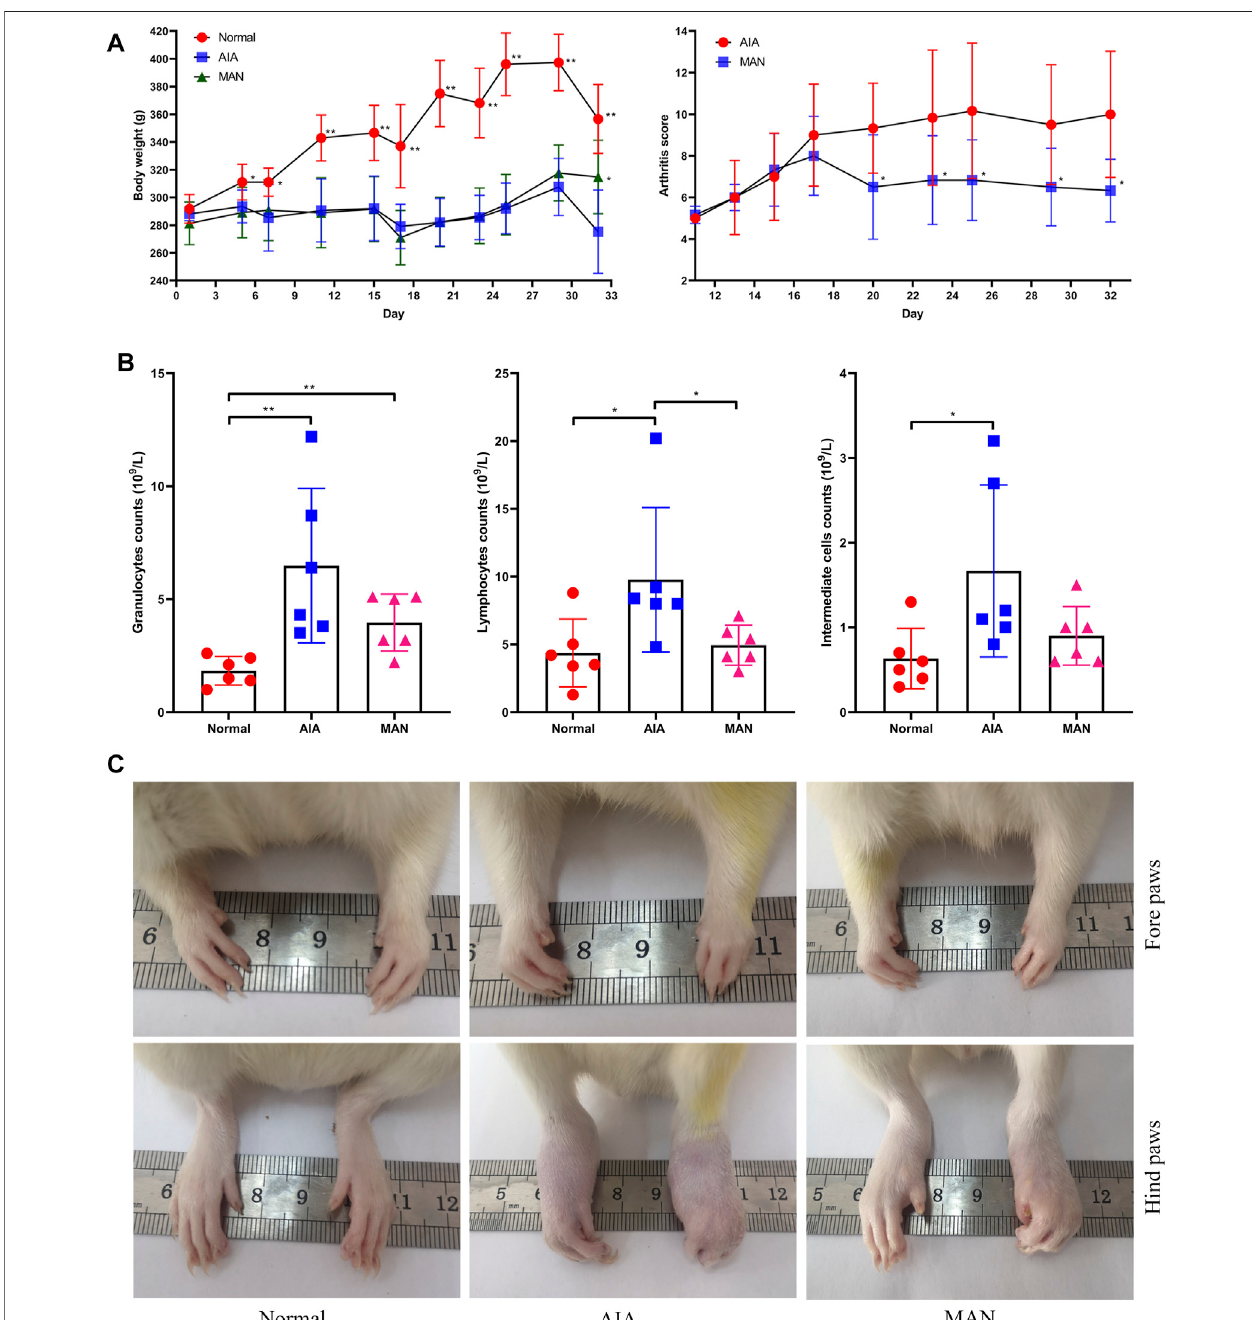
FIGURE 1 | MAN alleviated severity of AIA in rats after continuous oral treatment. (A) , periodic changes of arthritis scores and body weight of AIA rats ( n (cid:2) 6); (B) , CBC analysis of anticoagulation blood obtained upon the sacri fi ce of rats ( n (cid:2) 6); (C) , morphological observation of paws by the end of experimental period. Statistical signi fi cances in image A: * p < 0.05 and ** p < 0.01 compared with AIA model controls.